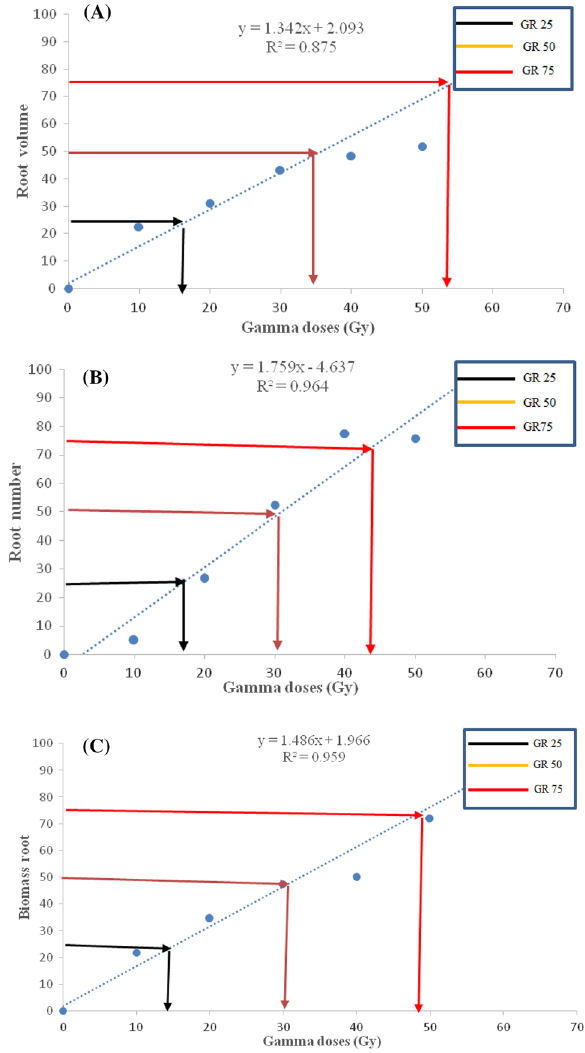
Figure 4. The negative effect of different gamma irradiation doses on growth reduction of root morphometric traits (root volume, panel A ; root number, panel B ; biomass root, panel; C ) of hardwood cutting of ‘Yaghouti’ grape ( Vitis vinifera L.)